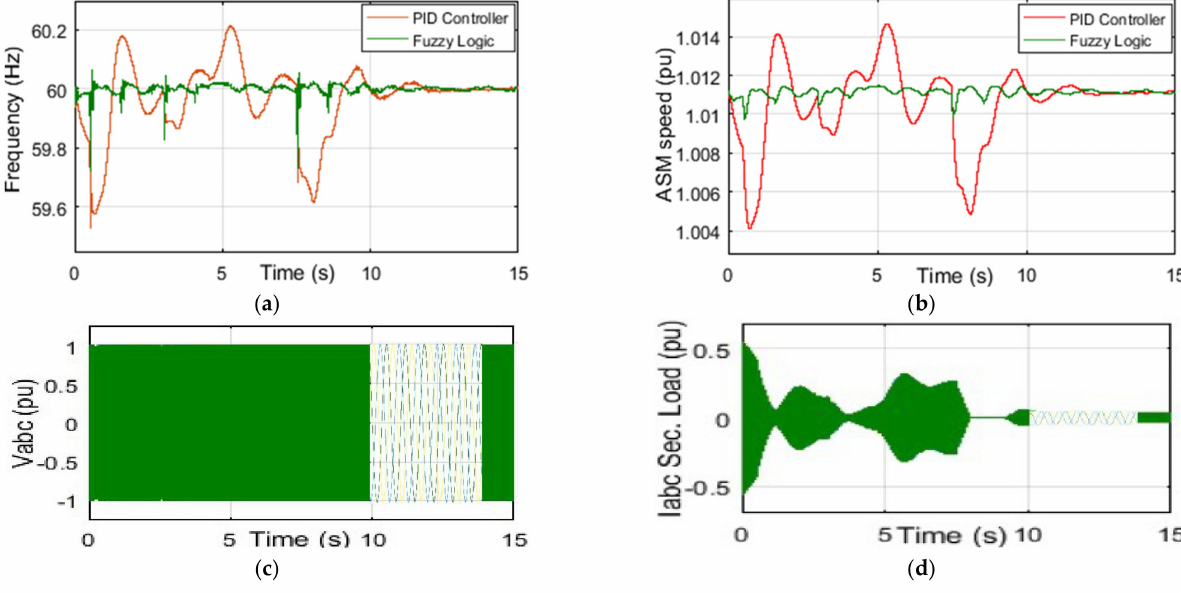
Figure 15. ( a ) Network frequency conditions. ( b ) Speed generated by ASM generator. ( c ) Voltage at load bus. ( d ) Current at SL, where the BESS is